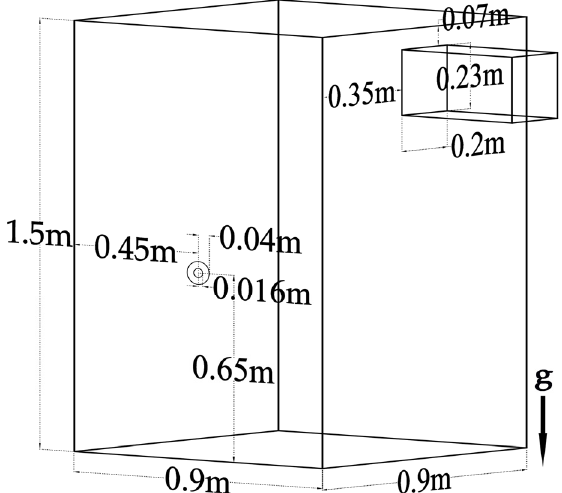
Figure 8. Geometry of the combustion chamber.